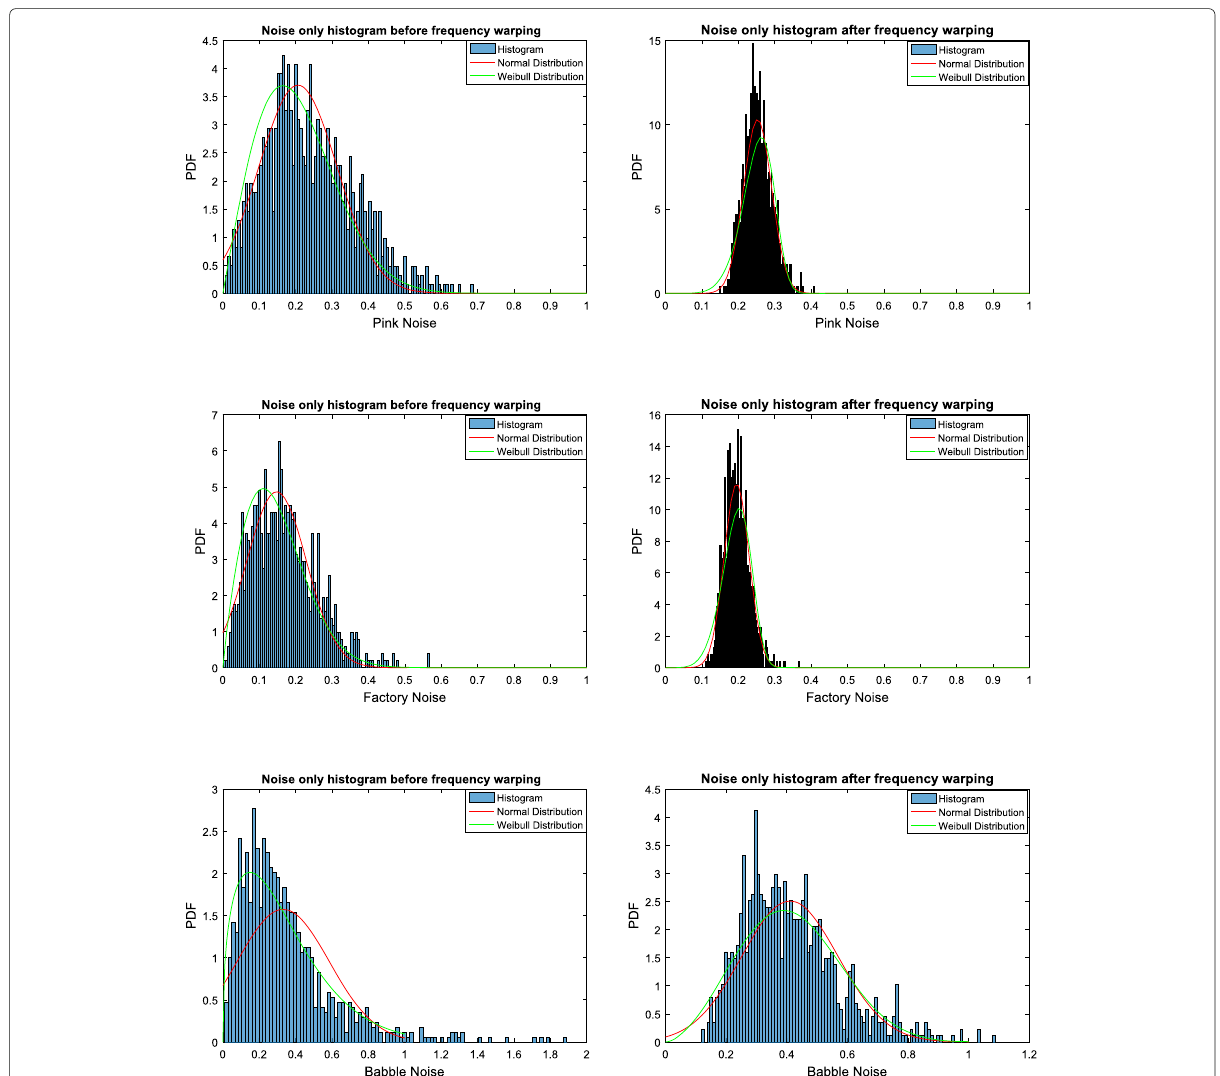
Fig. 9 Evaluation of bark scale-based frequency warping at the 6th critical band under different background noise: 1st row for pink noise, 2nd row for factory noise, and last row for babble